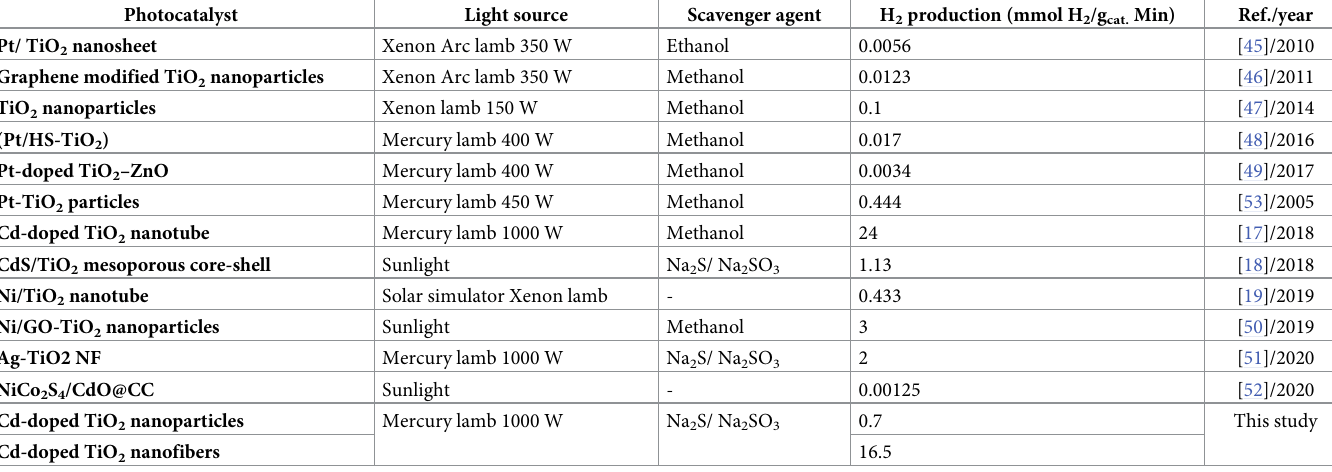
Table 1. A comparison of the hydrogen evolution rate for different nanocatalysts.